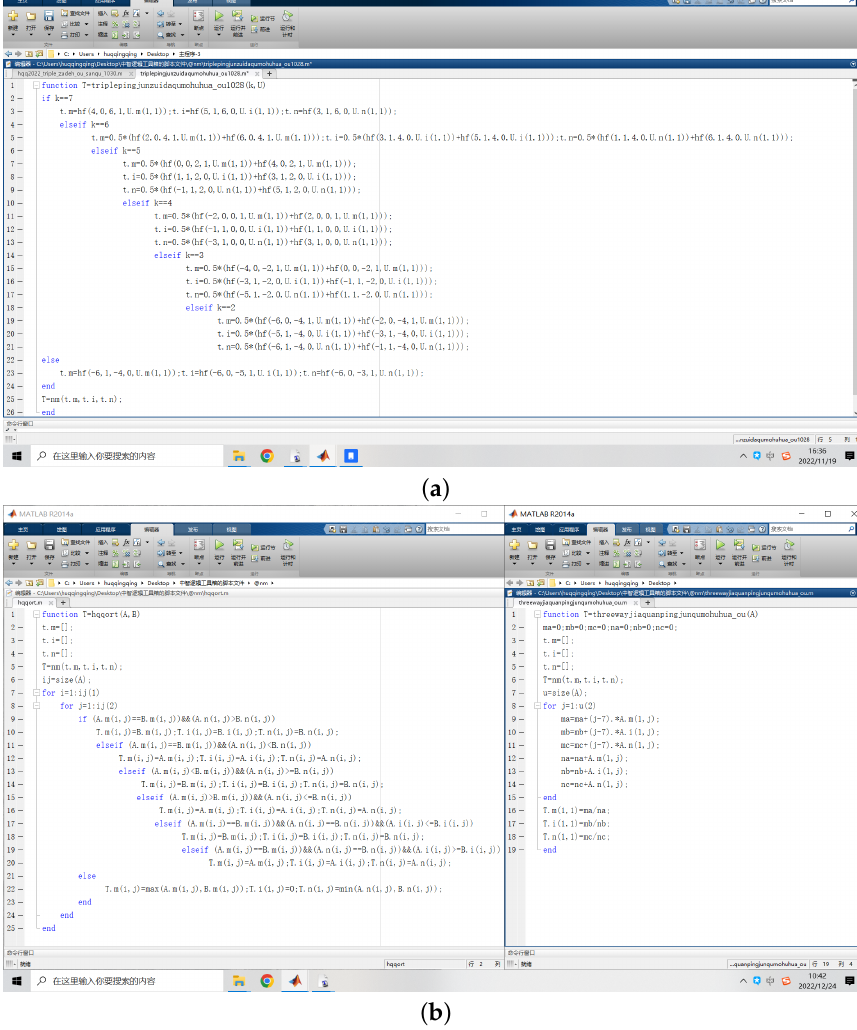
Figure 3. MOM defuzzification method ( a ) and WA defuzzification method ( b ).